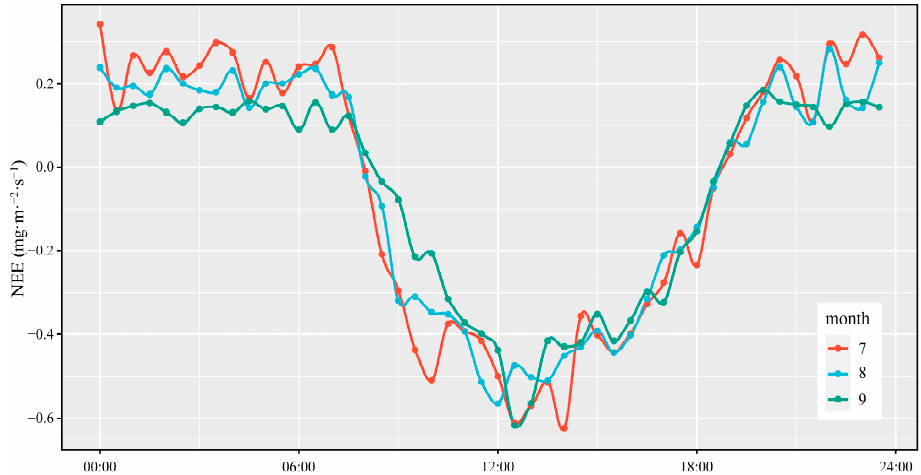
Figure 2. Month-average daily changes of net ecosystem exchange (NEE).